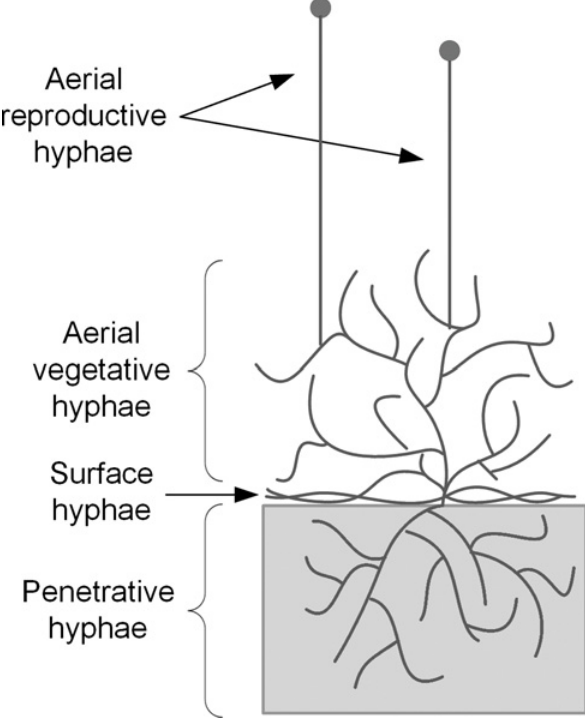
Fig 1. Simplified diagram of the growth of filamentous fungi on solid substrates. The different types of hyphae present are indicated.